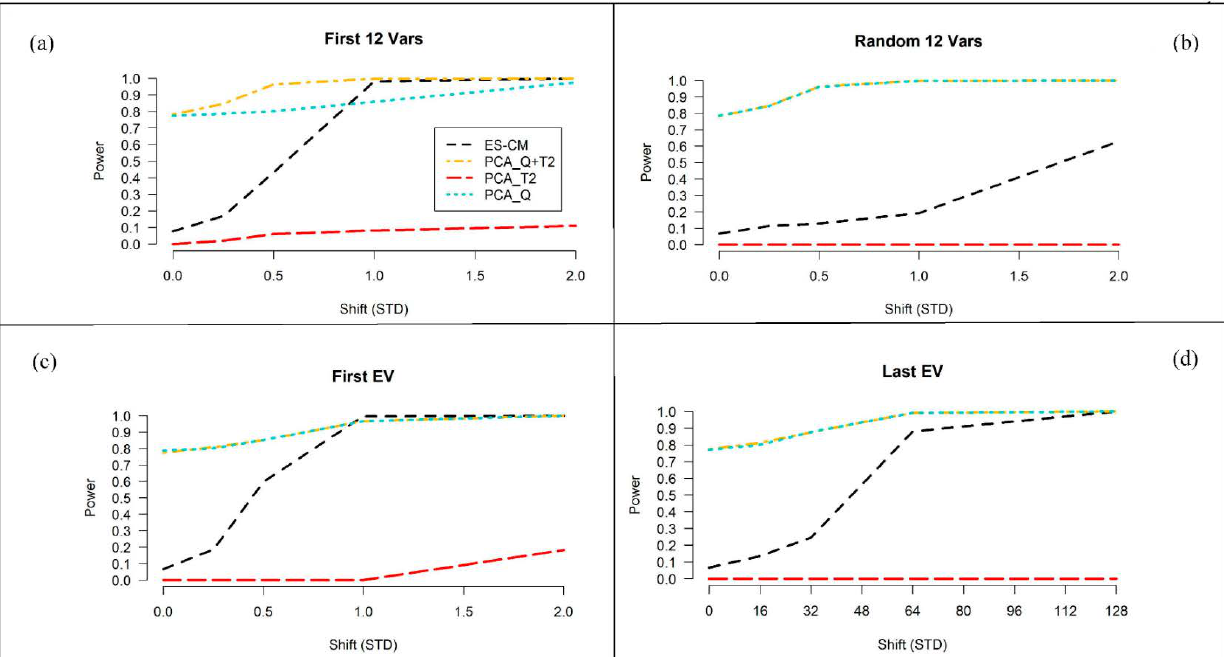
Figure 5. Percentage of correct detection of the introduced abnormality (over 200 simulations) for ES-CM based on “L T” shrinkage for the MD (with χ 2 —based critical limits) and for the standard PCA-based decision criteria (simulation 1). On the x-axis the magnitude of the shift (in standard deviations) in the mean between the reference population and the test sample and on the y-axis the percentage of correct detection of the introduced abnormality (i.e., power). The black line shows the detection percentage based on ES-CM, the red line the PC-based score distance alone, the cyan line the PC-based orthogonal distance only and the gold line the two PC-based measures combined. Each simulation setting consisted of N = 25 units and a (P = 250)-variate normal distribution with 0 mean and a type (iii) covariance matrix.In panel ( a ), the test data (N = 100, P = 250) has a mean shift for the first 12 variables of size (0, 0.25, 0.5, 1, 2). In panel ( b ), the test data has a mean shift in 12 random variables of size (0, 0.25, 0.5, 1, 2). In panel ( c ), shifts of size (0, 0.25, 0.5, 1, 2) were done along the first eigenvector. In panel ( d ), shifts of size (0, 16, 32, 64, 128) were done along the last